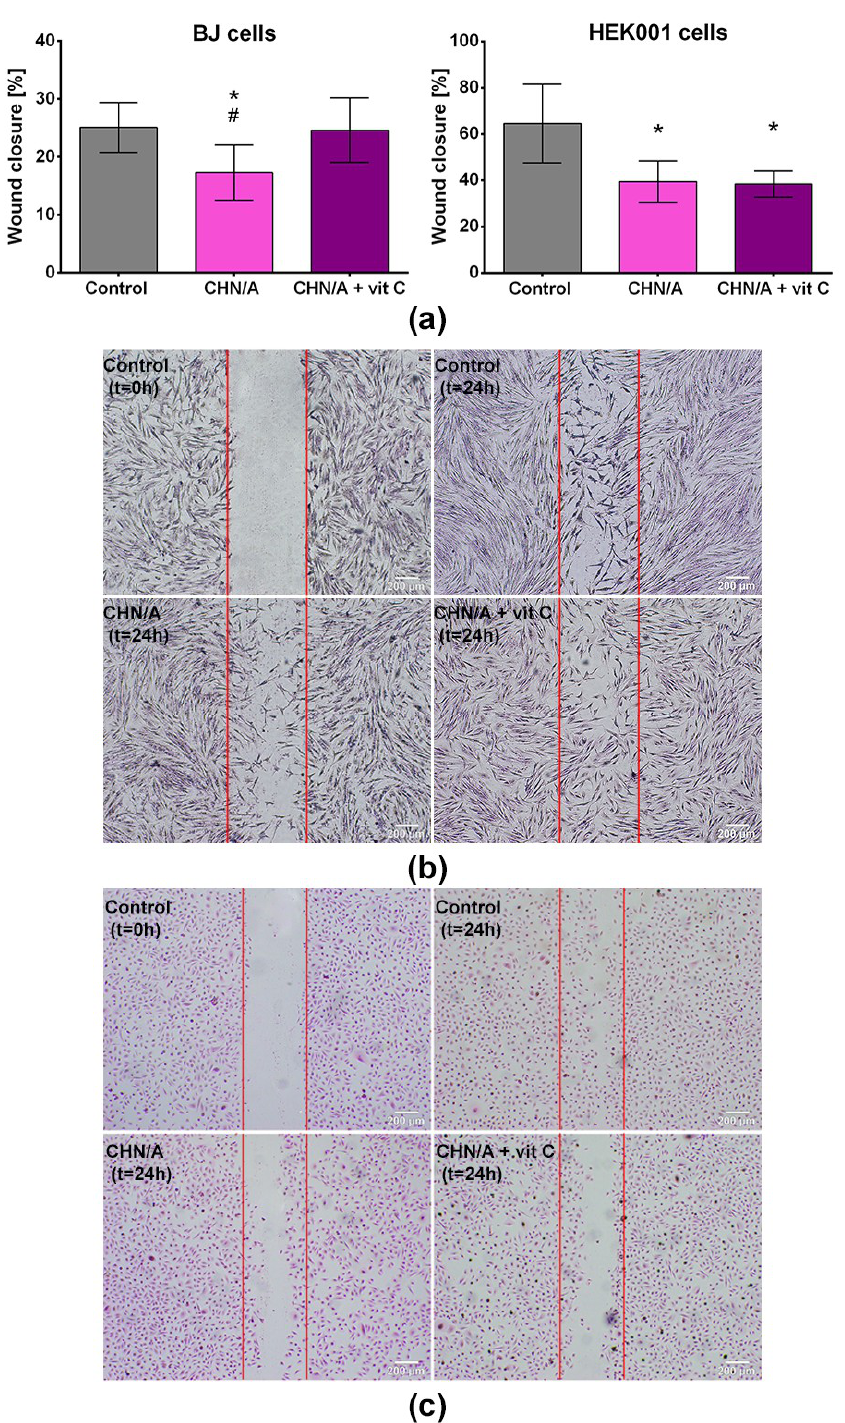
Figure 4. Cell migration determined by wound healing assay: ( a ) quantitative evaluation of wound closure (%) expressed as the percentage of the wound area covered by the cells 24 h after the scratching (* statistically significant results compared to control cells; # statistically significant results compared to CHN/A + vit C sample, n = 4 (four independent samples were tested), p value < 0.05, one-way ANOVA followed by Tukey’s test); ( b ) optical microscope images presenting scratch area covered by migrating BJ fibroblasts; ( c ) optical microscope images presenting scratch area covered by migrating HEK001 keratinocytes (control—cells cultured in the presence of culture medium, t 0 —wound area just after scratching, t 24h —wound area 24 h after scratching).